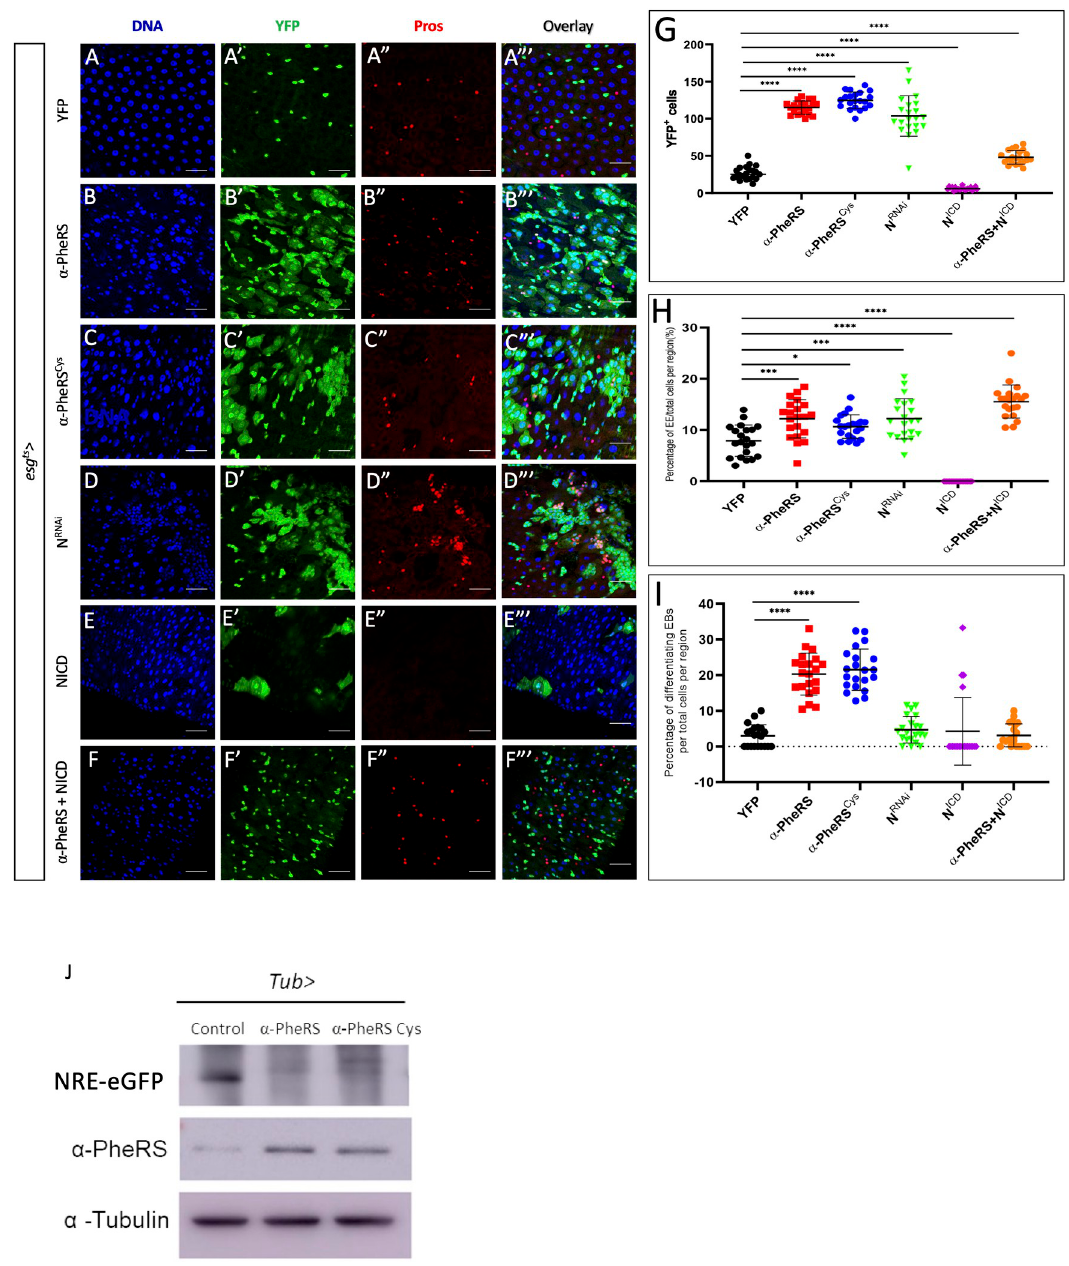
Fig 2. Elevated α -PheRS levels affect gut homeostasis, leading to additional progenitor cells, EEs, and differentiating EBs. (A-C”’) Elevated α -PheRS or α -PheRS Cys levels induced by the esg ts system (see Fig 1E for details) led to additional YFP-positive cells and also to the accumulation of EEs ( esg ts /+;UAS- α -PheRS (Cys) /+) . (D-D”’) RNAi knockdown of Notch (N) with the same esg ts system led to a similar phenotype as elevation of α -PheRS levels (UAS-N RNAi /+; esg ts / +) . (E-F”’) Elevation of α -PheRS levels rescued the depleted ISC pool caused by Notch over-activation (induced by expressing the NICD under esg ts control). (G) Quantification of YFP + cell numbers. (H) Proportional contribution of EEs to the total number of gut cells in the intestinal region analyzed. (I) Percentage of differentiating EBs among YFP + cells. In all experiments, EEs were visualized with the anti-Prospero antibody, YFP - / Hoechst + polyploid cells were counted as ECs. Animals were mated at 18˚C, and adults of the required genotypes were collected and shifted to 29˚C to inactivate Gal80 ts . Adult midguts were dissected from female flies after 5 days of induction at 29˚C. At least 10 guts were analyzed for each genotype. n = 10, �� p < 0.01, ��� p < 0.001, ���� p < 0.0001 in ANOVA tests. (J) The Notch activity reporter (NRE-eGFP) expresses GFP under the control of a Notch response element. Its levels drastically decreased upon elevated expression of α -PheRS or α -PheRS Cys in adult midgut ISCs ( esg-Gal4 , UAS-2XEYFP/+;tub-Gal80 ts /UAS- α -PheRS (Cys) , NRE-eGFP) . Female flies were collected 3 days after eclosure and cultured at 29˚C for 5 days before dissecting and harvesting their midguts.